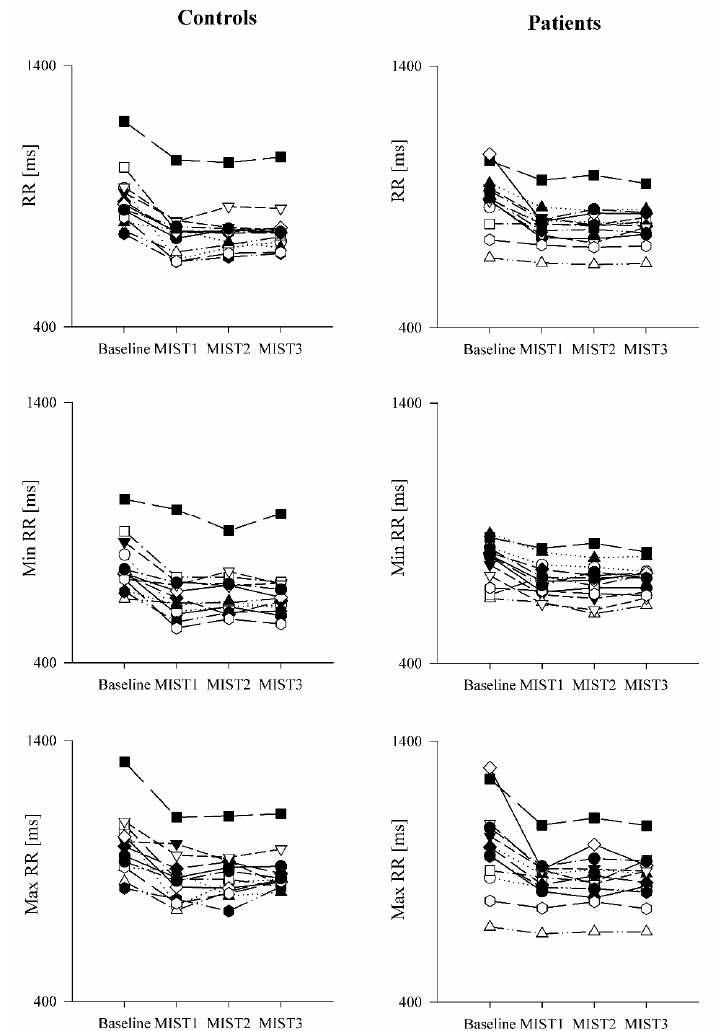
Figure 4. Trend of the ECG-derived parameters as a function of the experimental sessions in healthy controls and PAH patients. The scatter plots show the mean RR ( upper panels), minimum RR ( middle panels) and maximum RR ( lower panels) recorded in healthy controls ( left panels) and in PAH patients ( right panels) in resting condition (Baseline) and during the three different blocks of the Montreal Imaging Stress Test (MIST1, MIST2 and MIST3).